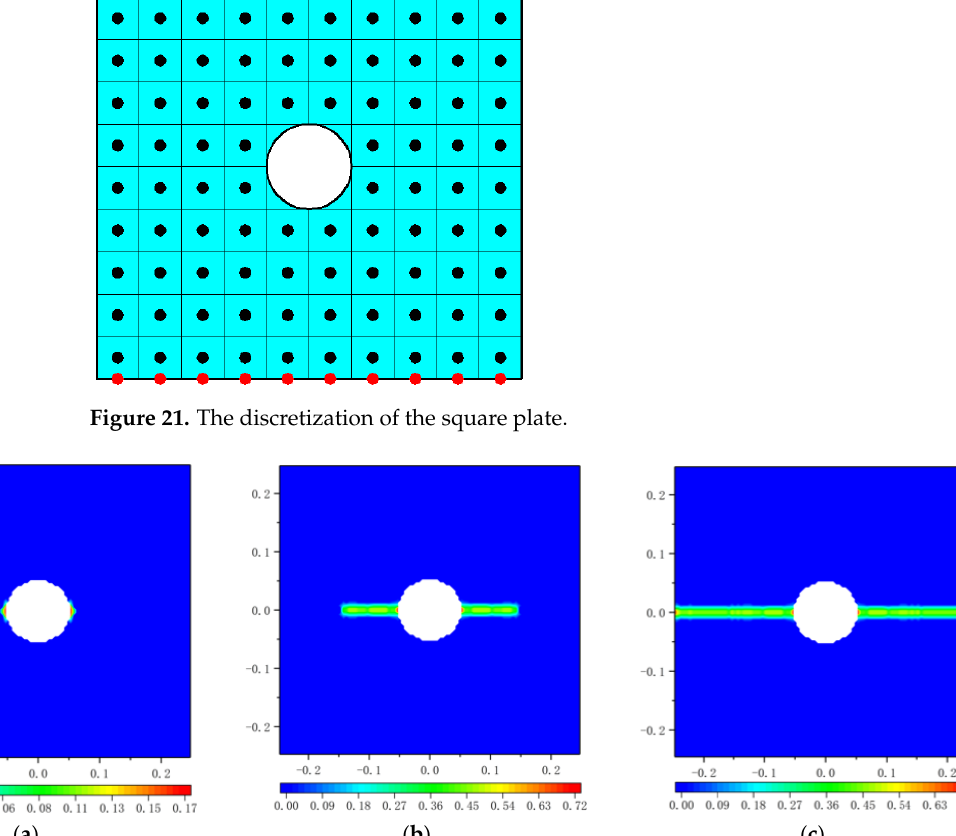
Figure 22. Damage plots for the square plate with a circular hole at the end of different time steps based on original PD: ( a ) 500 time steps; ( b ) 700 time steps; ( c ) 900 time steps.